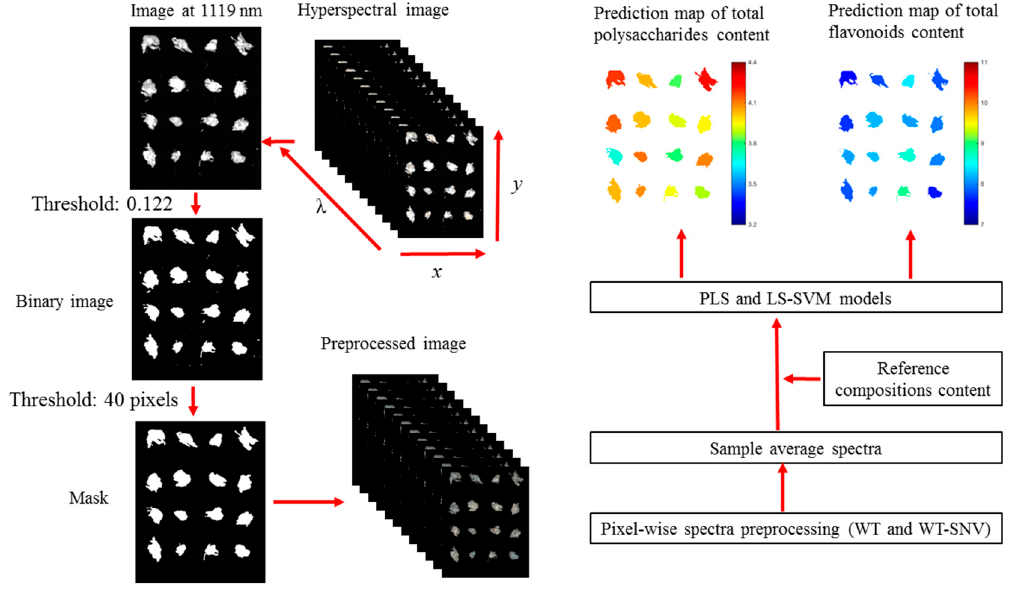
Figure 4. Flowchart of data analysis procedures.